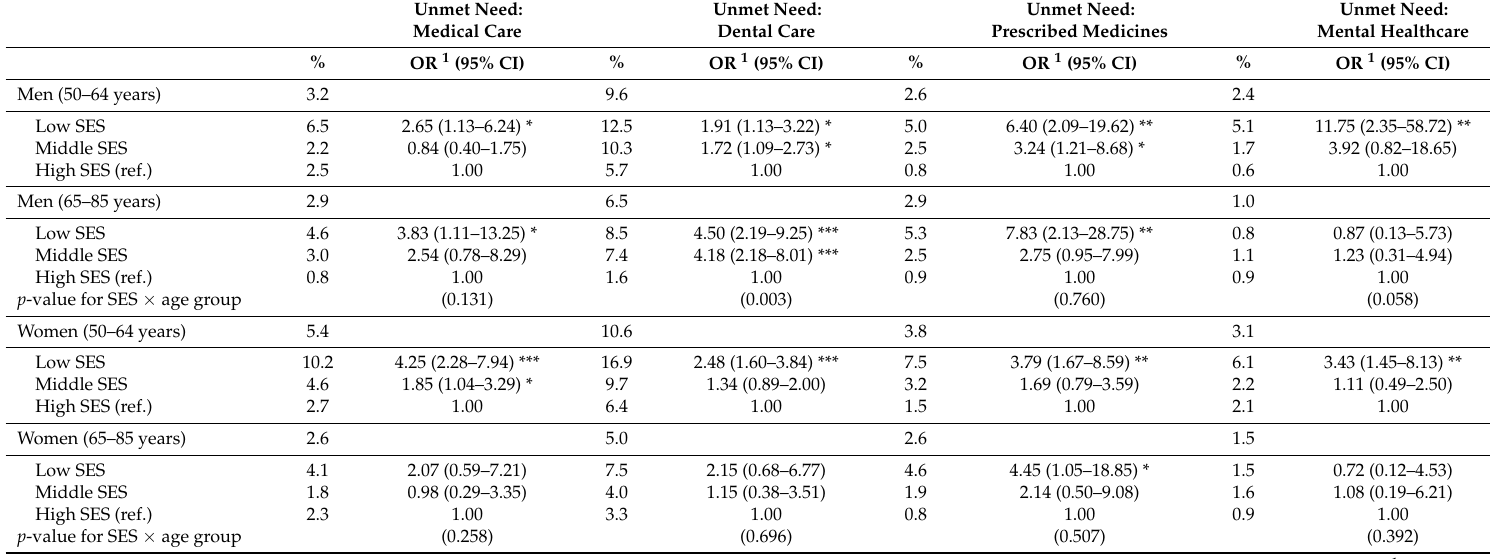
Table 3. Perceived unmet healthcare needs among elderly men and women in Germany with self-assessed need for healthcare, by socioeconomic status and age group.